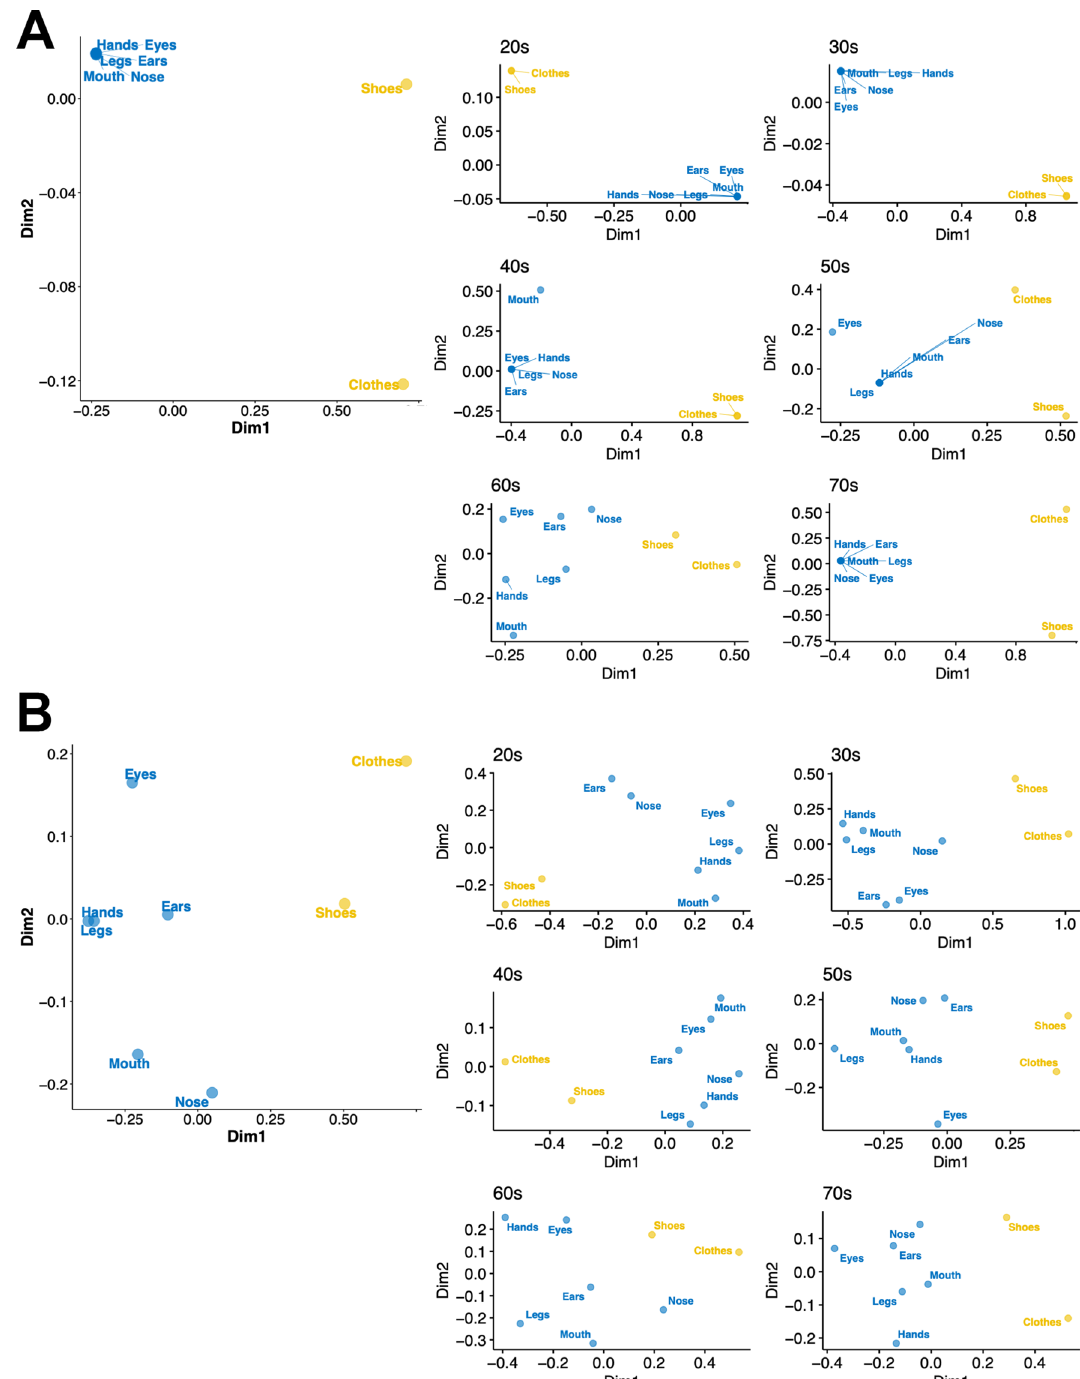
Figure 2. Internal configurations of the targets with multidimensional scaling analyses for ( A ) the ownership and ( B ) agency sensations. The left-side panel shows the whole participants’ data and right-side panels show each age group data. Plots were generated using R software version 4.0.1 (R Core Team (2020). R: A language and environment for statistical computing. R Foundation for Statistical Computing, Vienna, Austria. http:// www.R- proje ct.